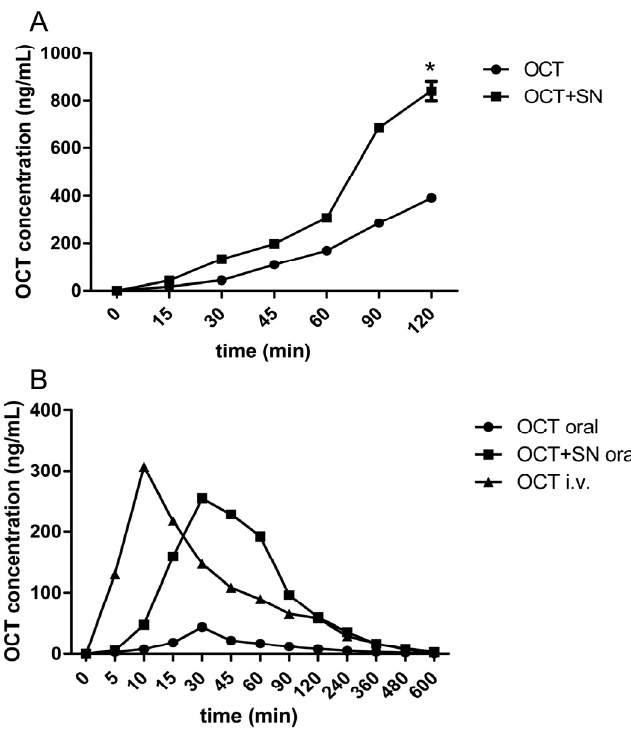
Figure 1. Effect of sinomenine (SN) on the absorption of octreotide (OCT) in